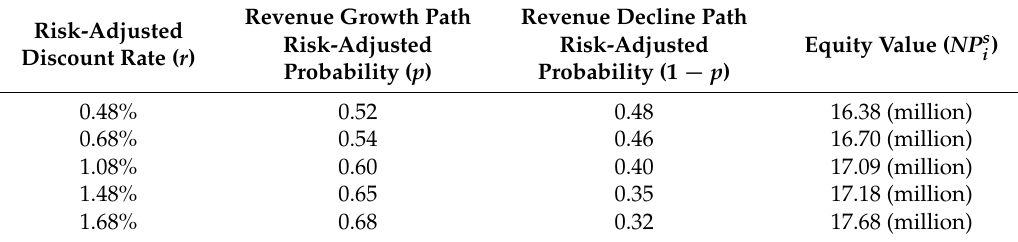
Table 2. The influence of the risk-adjusted discounted rate r on equity values.